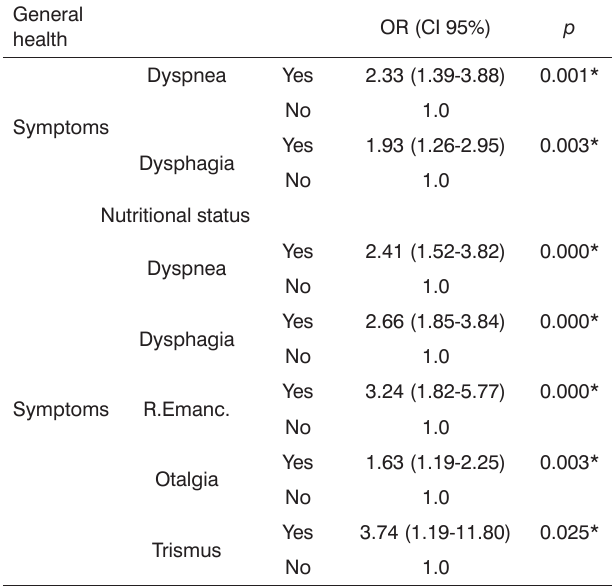
Table 6. Association between the general health and nutritional status of UADT SCC patients with symptoms*; estimated by the binary logistic regression model. Odds Ratio (OR) with a 95% confidence interval (CI).